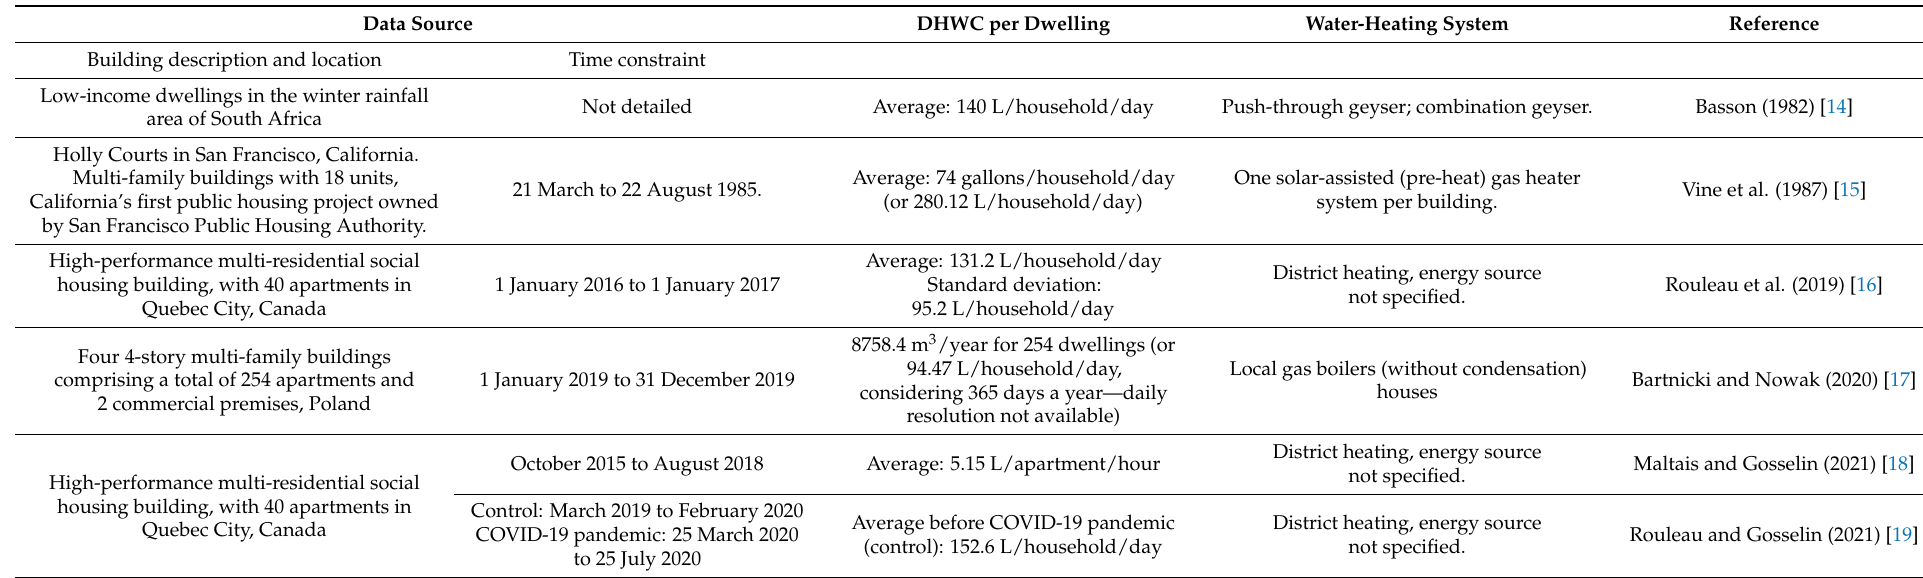
Table 1. DHWC data from monitoring studies in social